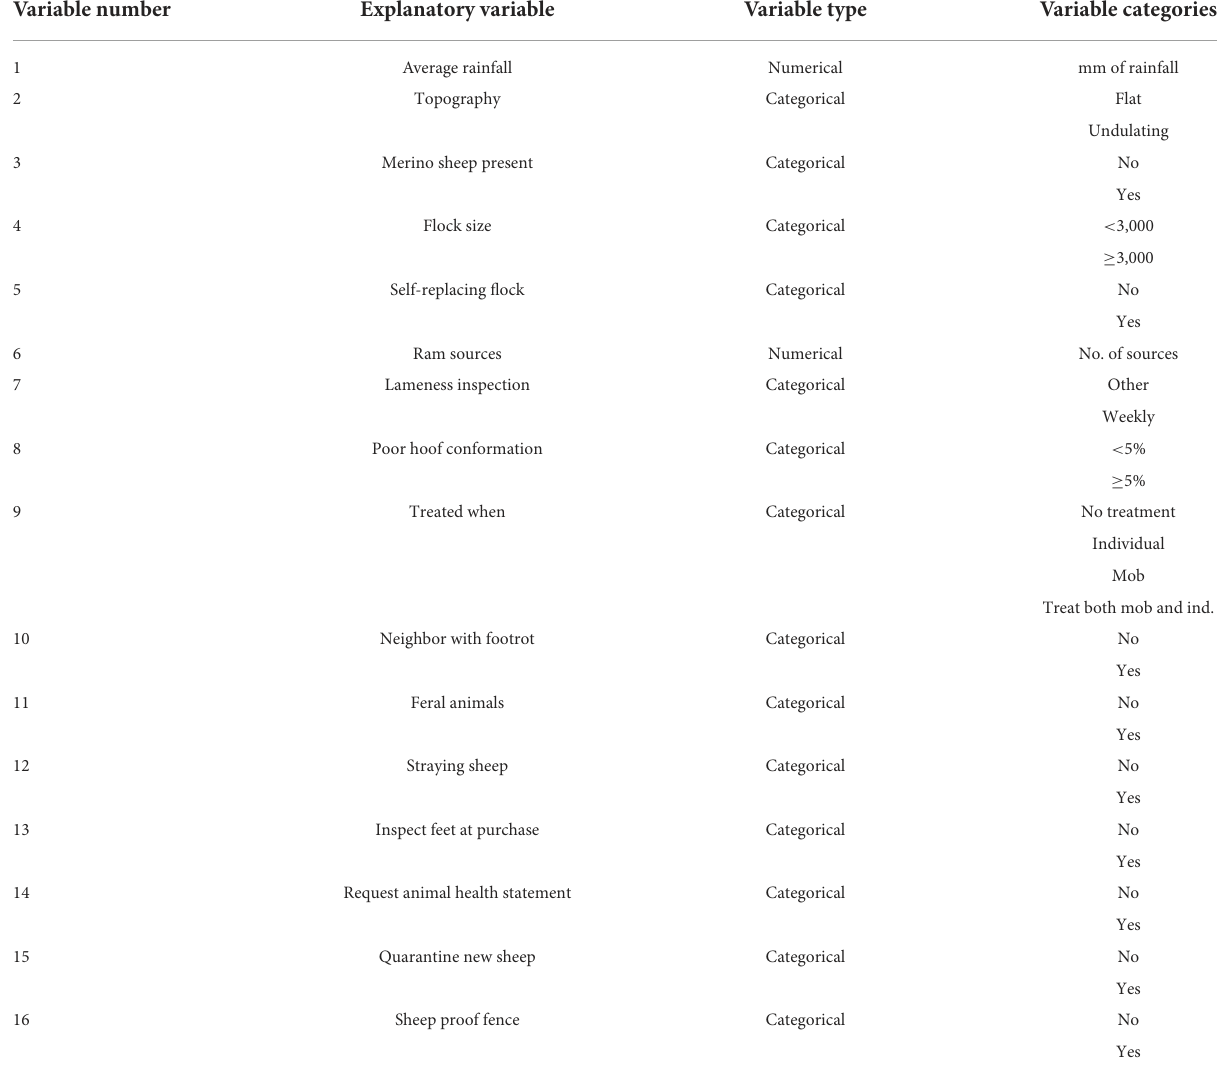
TABLE 1 The list of explanatory variables generated from the farmers’ response to the survey questions and the categories generated for each variable. Variable